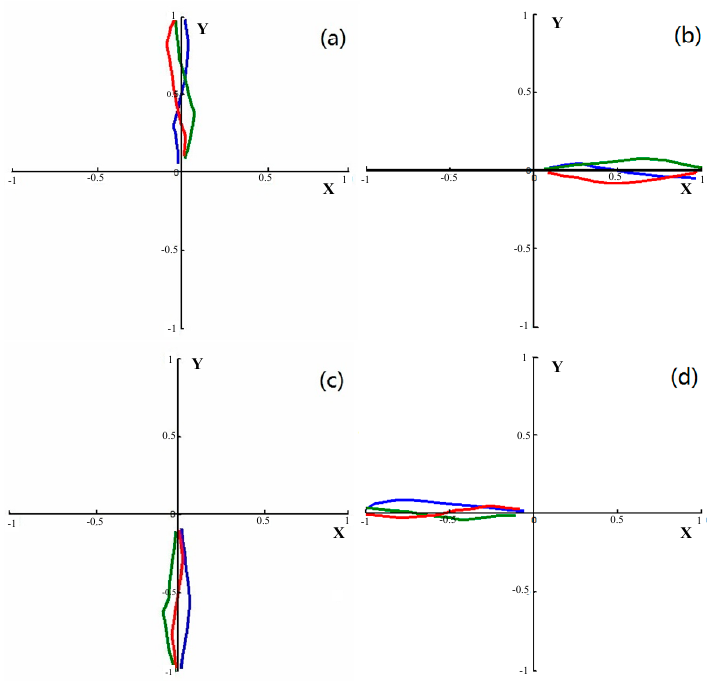
Figure 15. Normalized continuous trajectories of robotic arm moving towards target A ( a ), target B ( b ), target C ( c ), and target D ( d ) controlled by movement imagination EEG signals from subject 2.